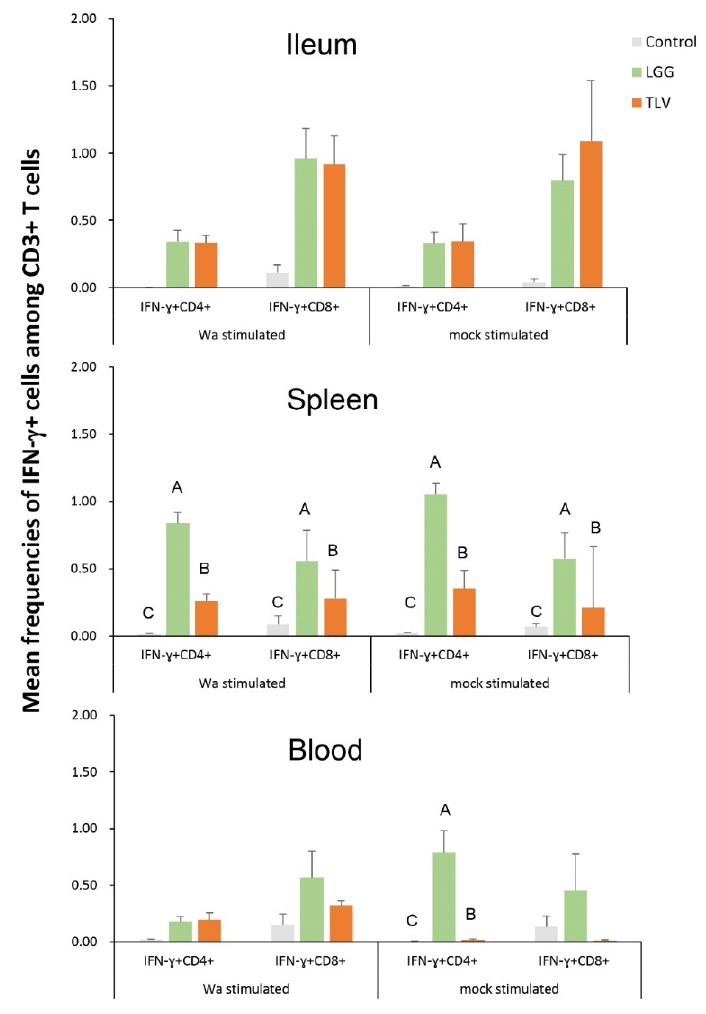
Figure 9. Frequencies of IFN- γ +CD4+ and IFN- γ +CD8+ T cells in the intestinal and systemic lymphoid tissues detected by flow cytometry pre-challenge (PD 28/PCD 0) in the LGG-fed, TLV-vaccinated, and mock control pigs. The MNC were stimulated in vitro for 17 h with semi-purified whole Wa HRV antigen or mock stimulated. Capital letters on top of bars (A, B, C) indicate significant difference, whereas shared letters indicate no difference among the groups for the same cell type (Kruskal–Wallis test, p < 0.05).